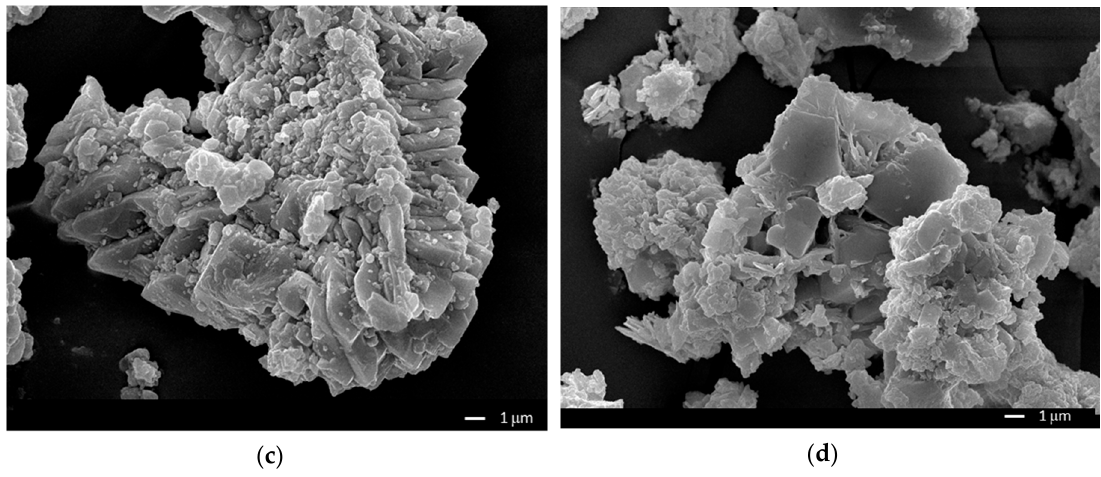
Figure 2. Scanning electron microscopy (SEM) images of 1 ( a ), 2 ( b ), 3 ( c ) and 4 ( d ).